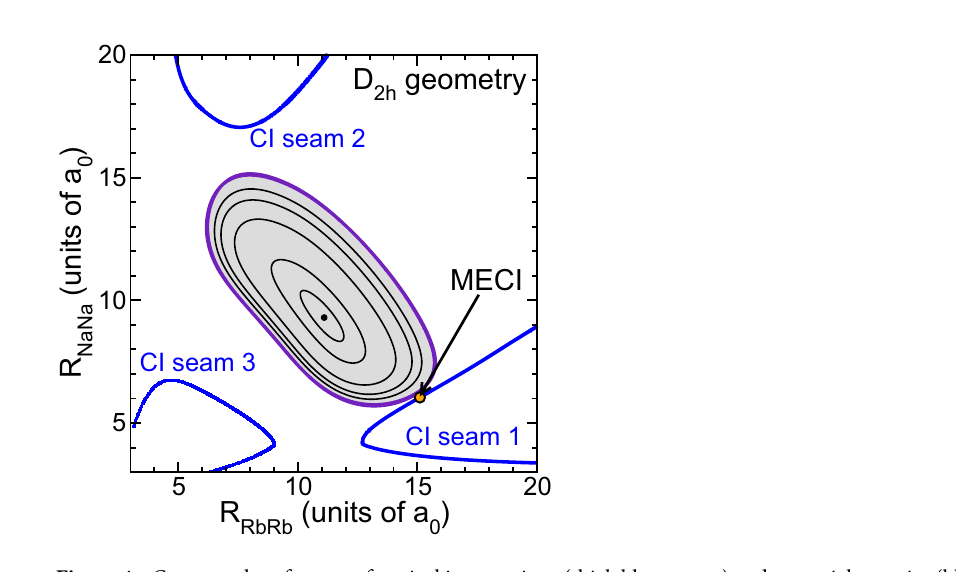
Figure 4. Contour plot of seams of conical intersections (thick blue curves) and potential energies (black curves) of Na 2 Rb 2 in planar D 2 h symmetry as functions of separations R NaNa and R RbRb . The orange marker indicates the minimum-energy conical intersection (MECI) on seam 1. The grey area indicates D 2 h geometries that are classically accessible for a cold NaRb+NaRb collision. Figure was prepared using Grace-5.1.22